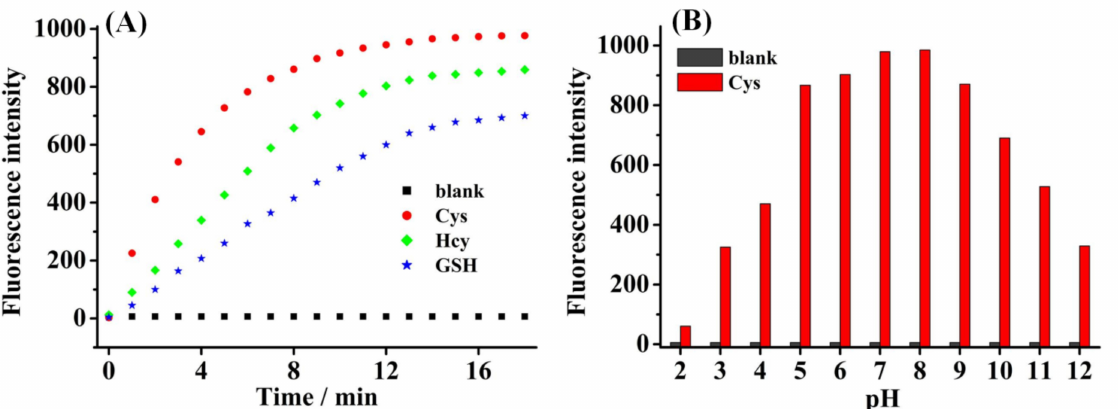
Figure 5. ( A ) Time-dependent fluorescence intensity of probe 1 (5.0 µ M) at 530 nm reacted with 100.0 µ M for Cys, Hcy, GSH in the solution containing PBS buffer (pH = 7.4, 50.0 mM) and 20% of DMSO. ( B ) pH effect on the fluorescence intensity of only probe 1 (5.0 µ M) (black) and in the presence (red) of Cys (100.0 µ M) at 530 nm ( λ exc = 413 nm, and t = 15